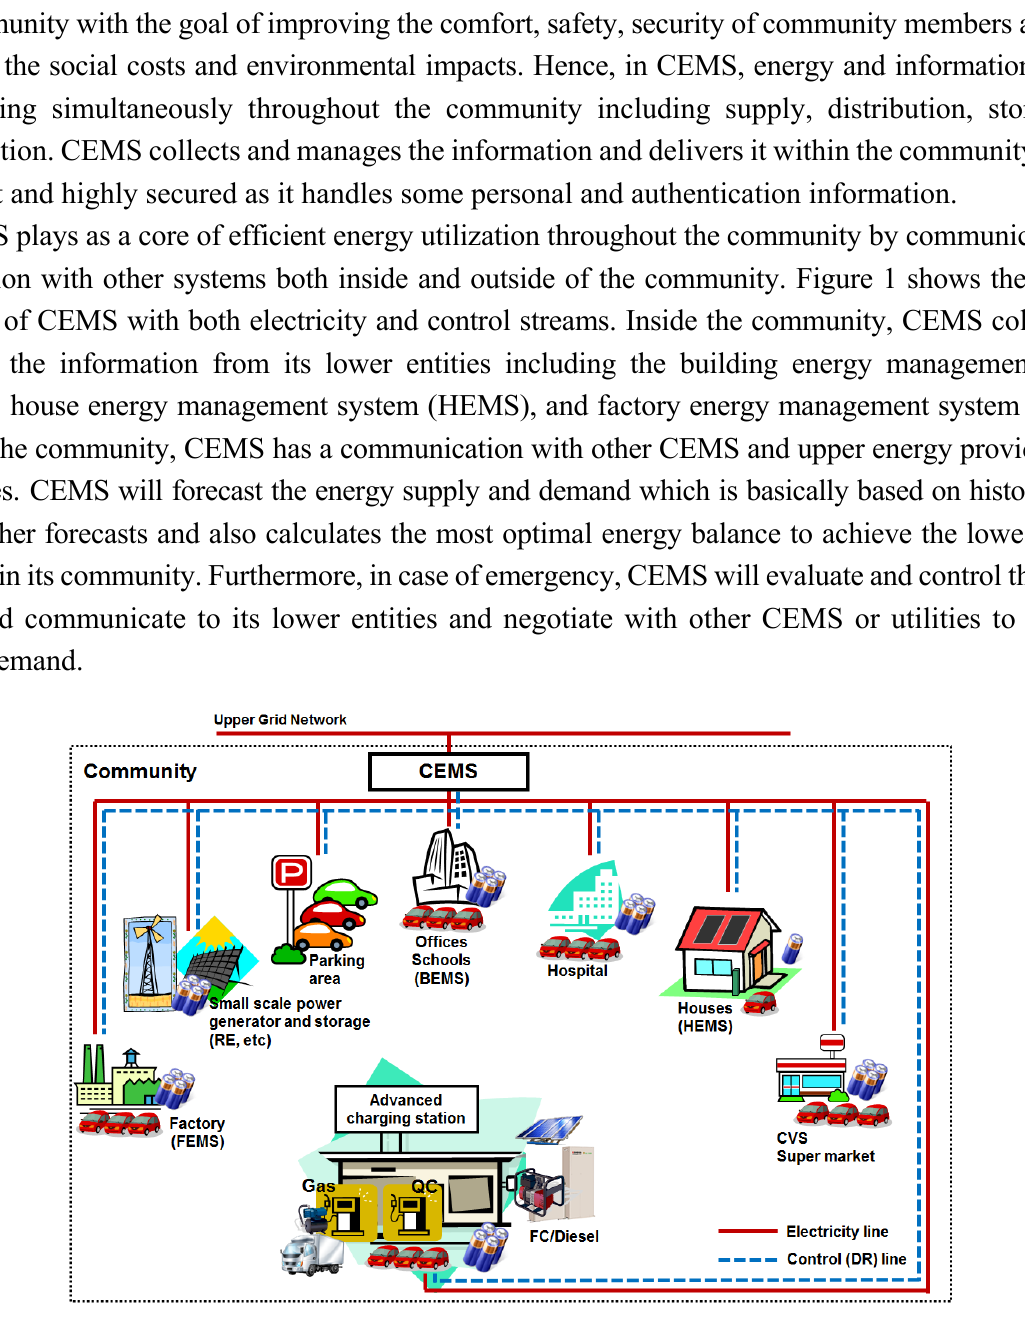
Figure 1. Possible structure of CEMS (community energy management system) including both electricity and control